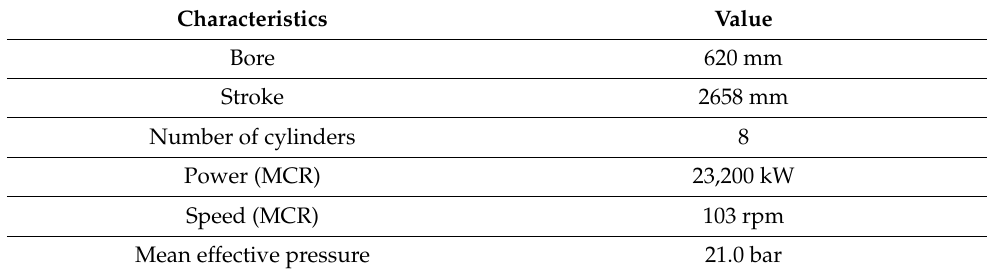
Table 3. Basic characteristics of a low-speed diesel engine WinGD X62-B (Data from: [36]).